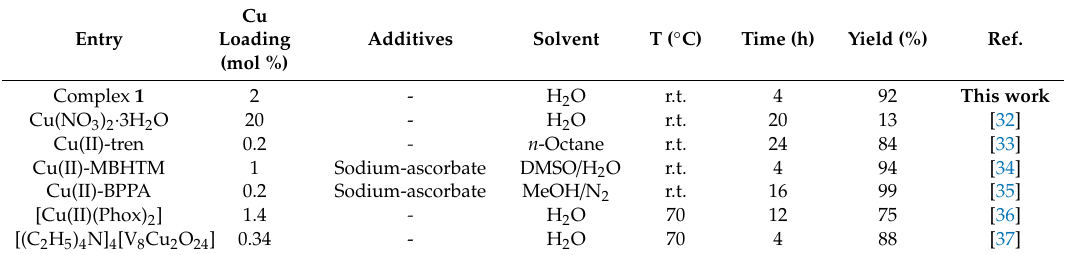
Table4. Comparisonofthecatalyticperformanceof 1 withotherliteraturereportsinCuAAC reactions a